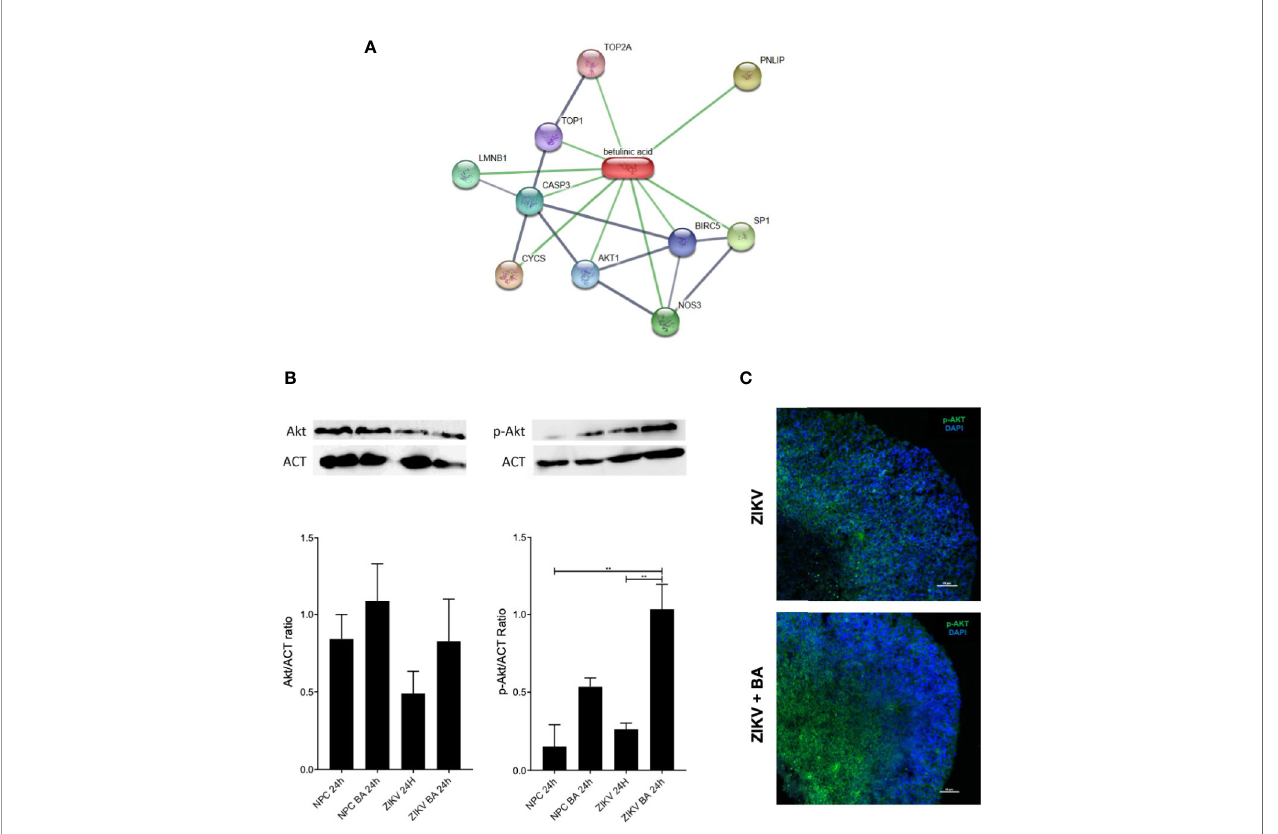
FIGURE 5 | Betulinic acid displays neuroprotective effect on neural progenitor cell (NPCs) population through activation of AKT signaling pathway. (A) Gene interaction map overlapped with betulinic acid via the STITCH database. Stronger associations are represented by thicker lines. Protein-protein interactions are shown in grey and chemical-protein interactions in green. (B) Protein expression levels of AKT and phosphorylated AKT in ZIKV-infected NPCs pool after 48-h treatment with betulinic acid at the concentration of 10 m M. (C) Representative confocal microscopy images of BA-treated brain organoids incubated for 7 dpi at the concentration of 10 m M stained for AKT and phosphorylated AKT (p-AKT). Multiplicity of infection (MOI) of 1. ** p < 0.005. Values represent the mean ± SEM of three replicates. MOI of